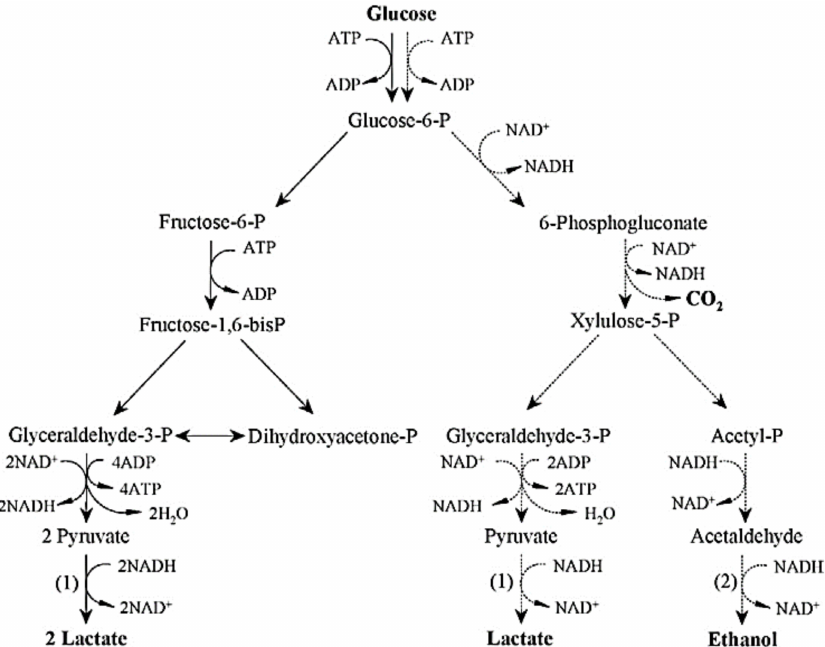
Figure 1. Metabolic pathways of homofermentative (solid line) and heterofermentative (dotted line) lactic acid bacteria: P, phosphate; ADP, adenosine 5 (cid:48) -diphosphate; ATP, adenosine 5 (cid:48) -triphosphate; NAD + , nicotinamide adenine dinucleotide; NADH, nicotinamide adenine dinucleotide (reduced form); (1), lactate dehydrogenase; (2), alcohol dehydrogenase (from Reference [8], licensed under CC BY-NC 4.0 at https: // www.ftb.com.hr / 80-volume-44-issue-no-2 / 445-biotechnological-production-of-lactic-acid-